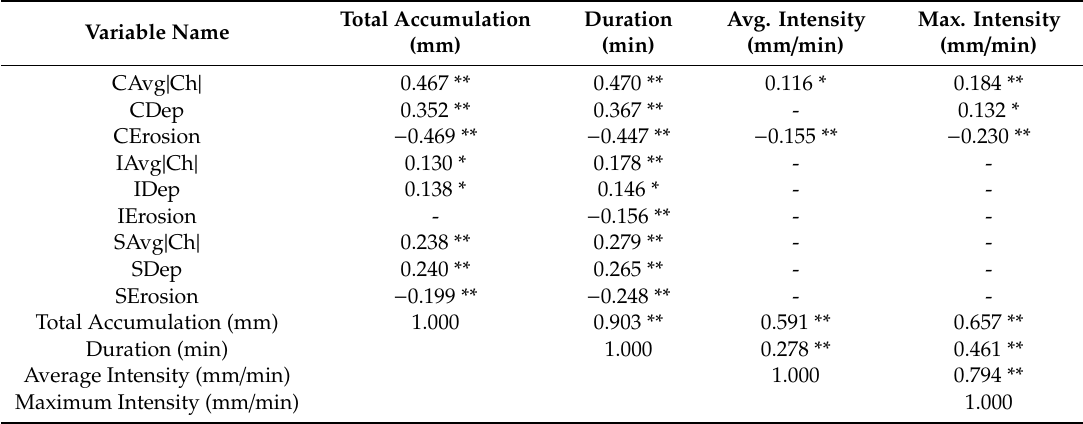
Table 3. Spearman’s correlation coe ffi cients for erosion variables and precipitation parameters. C, channel; I, interfluve; S, sidewall. Only significant correlations are shown (* significant at α = 0.05, ** significant at α =